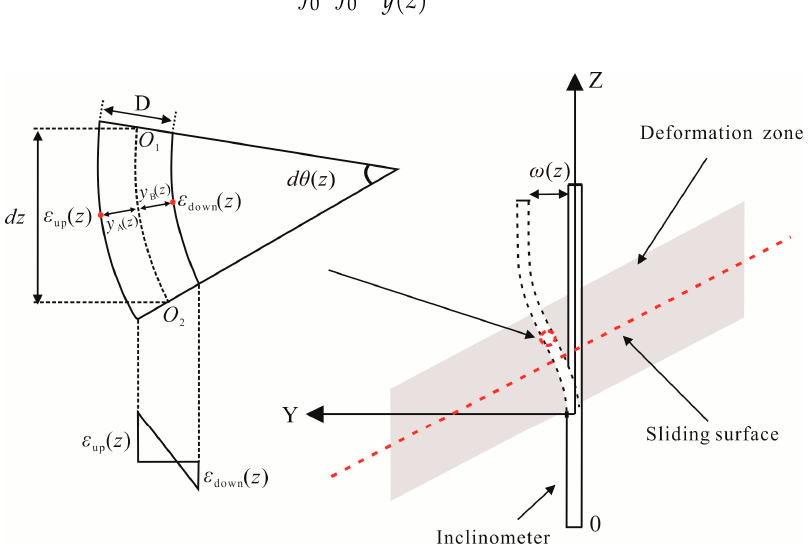
Figure 2. Principle of FBG inclinometer displacement calculation.